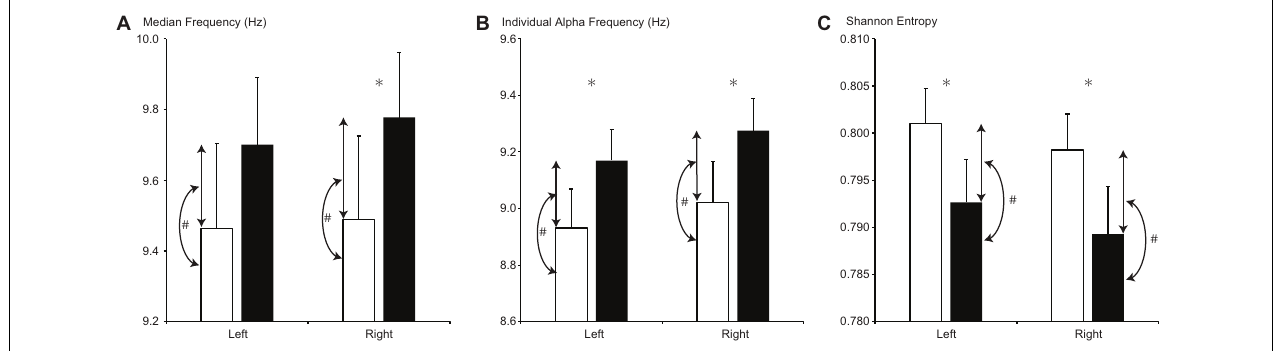
FIGURE 3 | Changes in (A) median frequency, (B) individual alpha frequency, and (C) Shannon entropy between the menstrual period (MP, open columns) and the period outside of menstruation (OP, filled columns). Error bars represent the grand mean of standard errors over bootstrapped iterations. Asterisks ( ∗ ) indicate statistically significant differences (after false-discovery rate (FDR) correction) between the two periods. Hash tags (#) indicate statistically significant correlations (after FDR correction) between the value of the parameter in each period and its change.